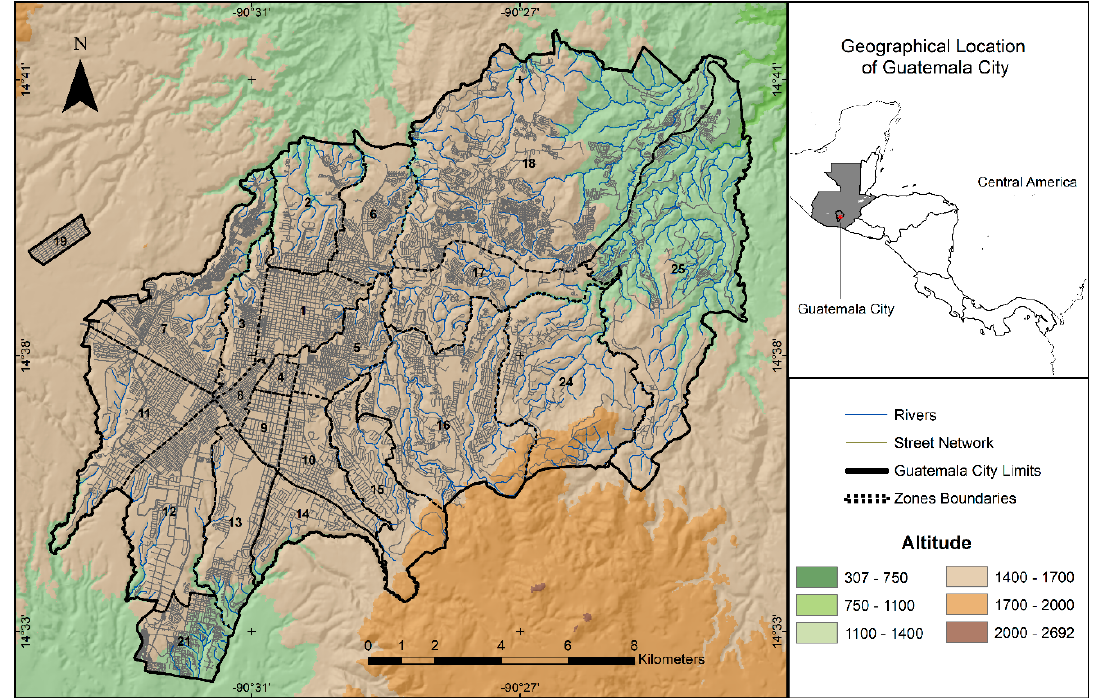
Figure 1. Guatemala City geographical location. Upper panel to the right shows Guatemala City inside the Republic of Guatemala and the rest of Central American countries. Map illustrates Guatemala City situation in the Central Highlands [1533 m]. Numbers indicate the city’s zones. Own sketch.